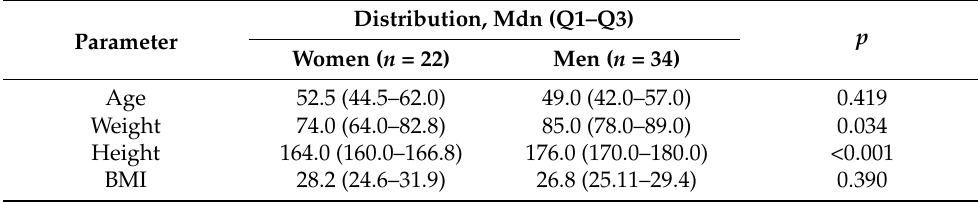
Table 1. Sociodemographic data of the study sample, N obs (the sample size) = 55.